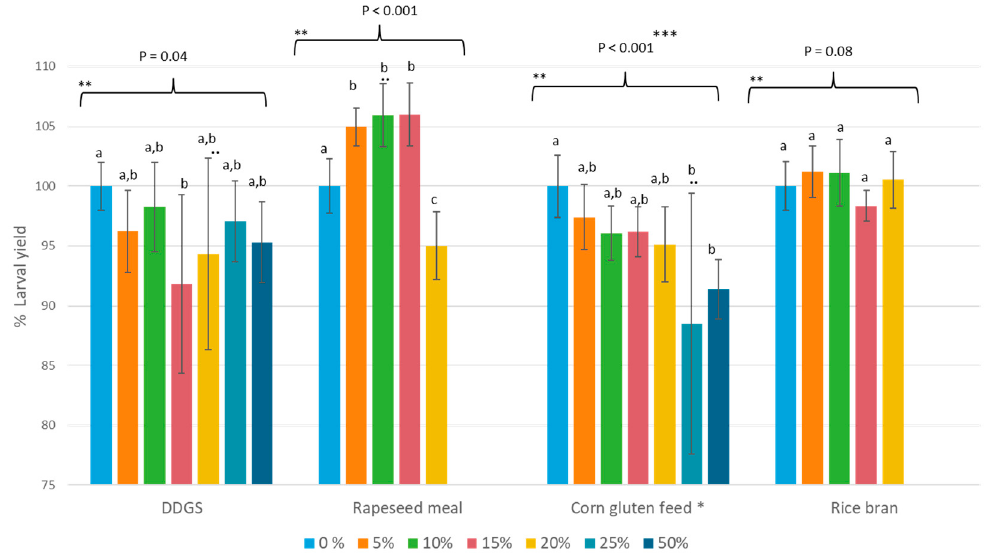
Figure 2. Percentage larval yield of the mixed diets grouped per side-stream. The bars indicate the percentage of wheat middlings that were replaced by the side-stream, where 0% refers to the reference diet ( n = 8). * Reference diet was based on a fivefold repeat; ** within this data set, averages that are not labeled with the same letter are significantly different on the basis of the ANOVA-Tukey analyses. The average of the reference diet that was included in the same trial was used as the denominator in Equation (2). ** These data had a p -value of 0.03 for the Shapiro–Wilk test; *** these data showed no equal variances of population, and the Kruskal–Wallis analysis was applied.